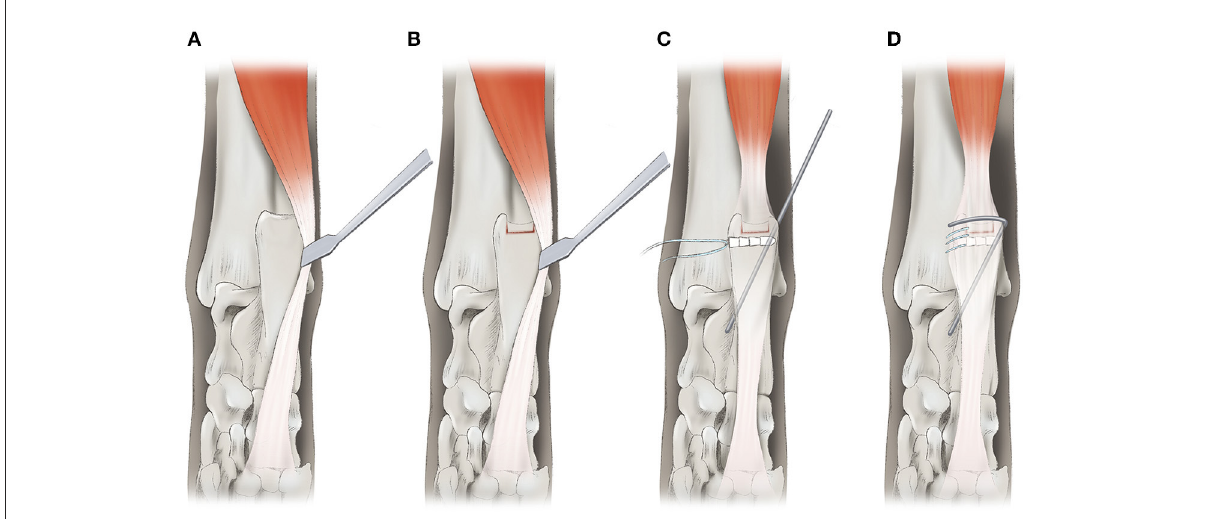
FIGURE3 A schematic diagram of block recession calcaneoplasty (A,B) . The bone flap was made by using a hobby saw and mini lambotte osteotome (B) . Deepening of the calcaneal tuber was performed using a high-speed burr and the bone flap was replaced on the cancellous bone bed. The retinaculum was repaired using a 2.4 × 8.5mm biocomposite suture anchor (SutureTak; Arthrex Inc. Naples, FL) and 2-0 non-absorbable braided suture (Fiberwire; Arthrex Inc. Naples, FL) in simple continuous pattern (C,D) . A temporary restraining pin was placed on the lateral aspect of calcaneal tuber to prevent reluxation of SDFT tendon.